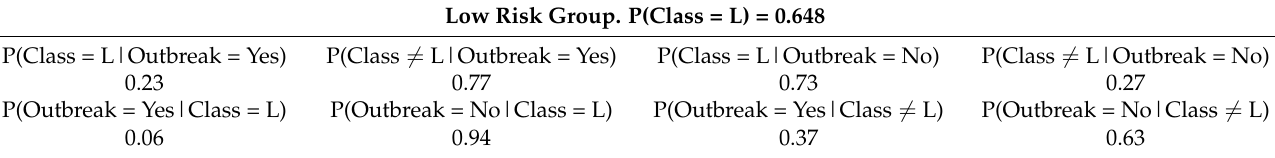
Table 1. Average classification performance in terms of P(Outbreak|Class) (i.e., probability of outbreak (Yes/No) given the assigned risk class, L) and P(Class|Outbreak) (i.e., probability of the assigned risk class given the outbreak) at the low action-thresholds (predicted risk = 0.015).